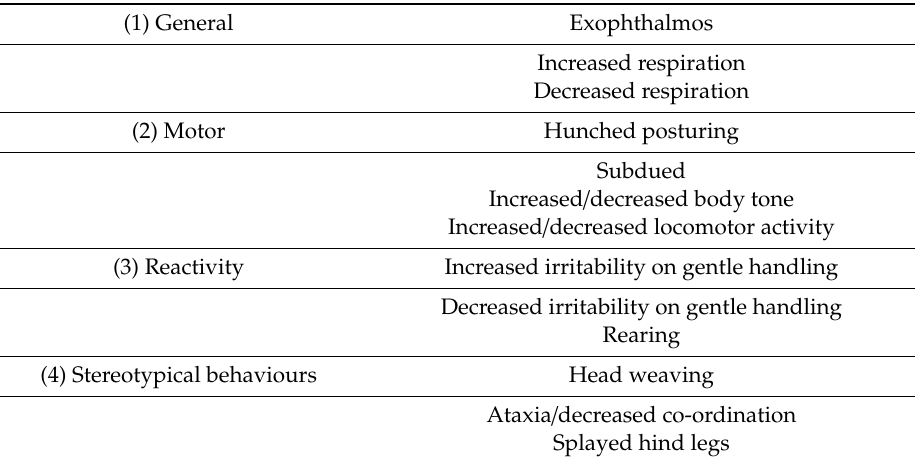
Table 2. Behavioural dysfunction score (score 1 for any behavioural aberration in each category to maximum score